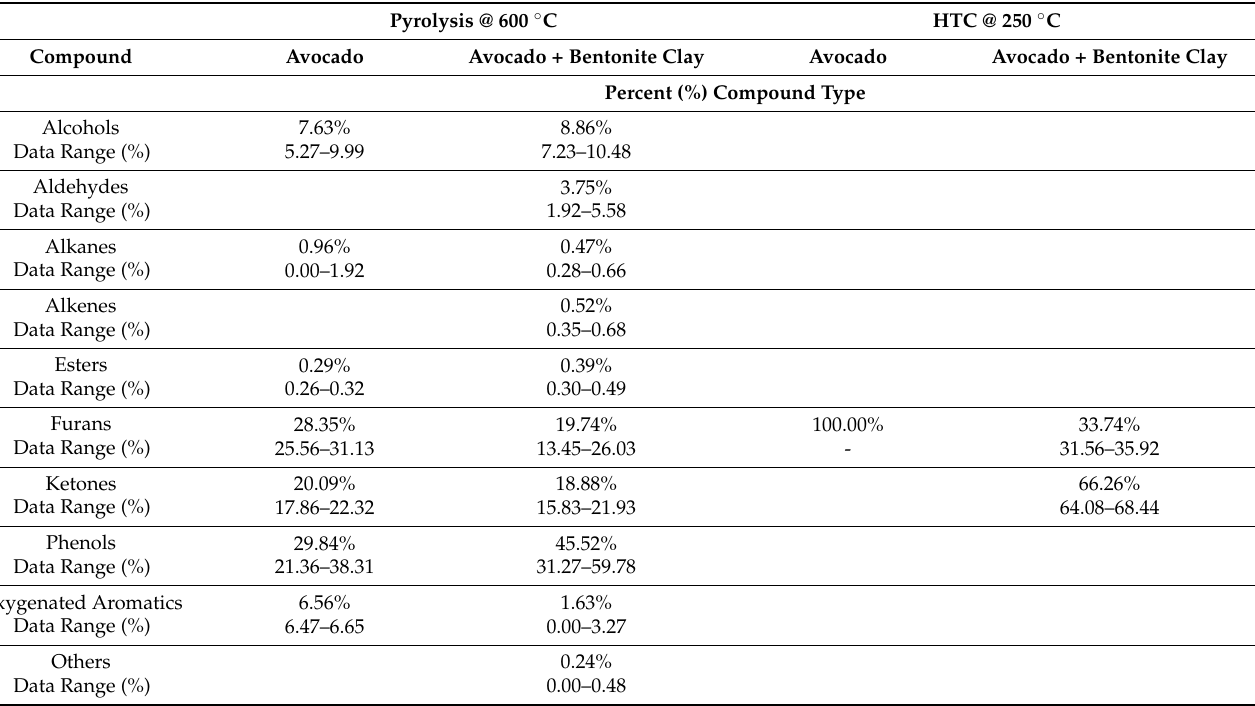
Table 1. Distribution of compound species detected in the GC-MS analysis of bio-oils derived from pyrolysis and HTC of avocado pits and avocado pits + bentonite. The reported values represent the percentage of each compound type out of the detectable compounds in the bio-oil. The average of two data points and the data range are presented. Total concentrations of detectable compounds ranged 30,000–50,000 mg compound/kg